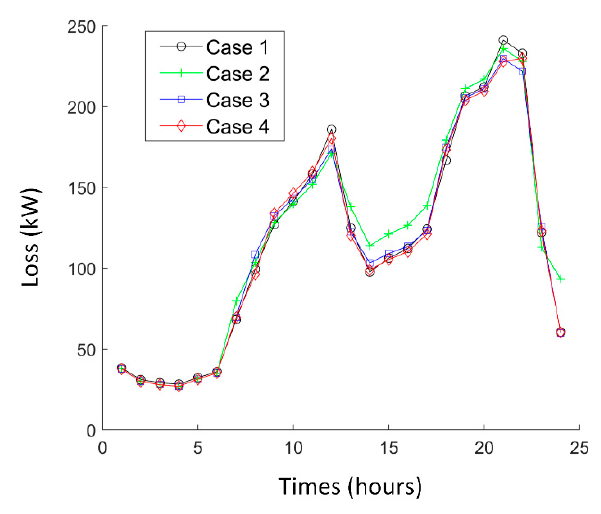
Figure 6. Time series of network losses by cases 1 to 4. Table 2. Network losses, device adjustment times and time consumed by cases 1 to 4.